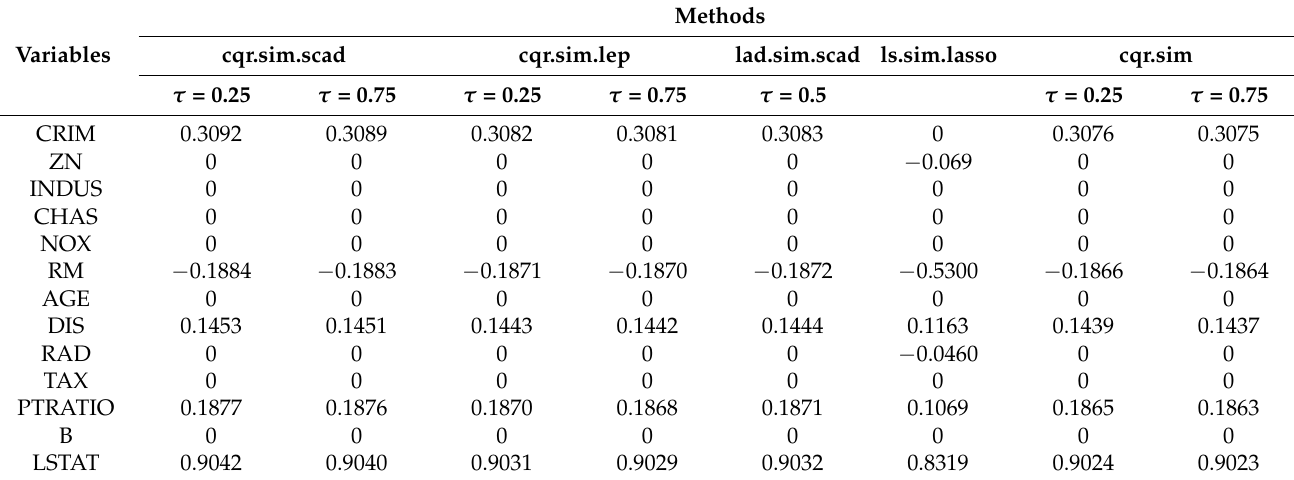
Table 4. Coefficient estimates for Boston housing